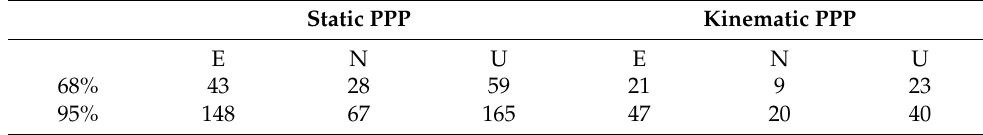
Table 6. Convergence time of the QF method (unit: min) (G/R). Static PPP